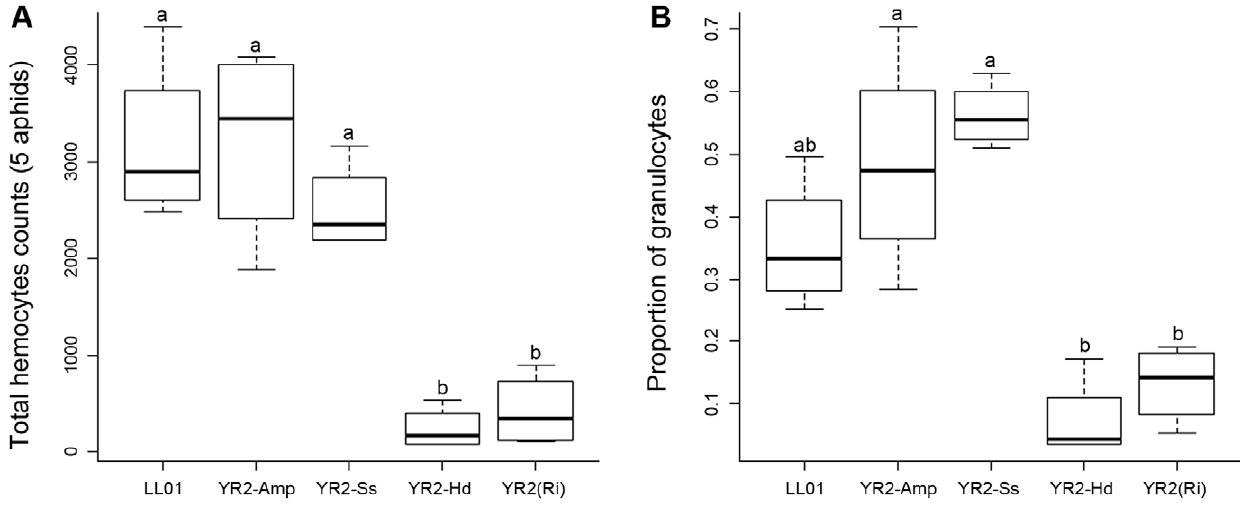
Figure 5. Total hemocyte counts (THC) and granulocyte proportions from AHPs of the different lines. Box-plot representations of the THC (A) and the proportion of granulocytes (B), estimated on F-actin stained AHPs (pools of 5 adults per AHP), for aphid lines listed in Table 1. Box- plots with the same letter have means that are not significantly different (TukeyHSD, alpha=5e-03, n=4).